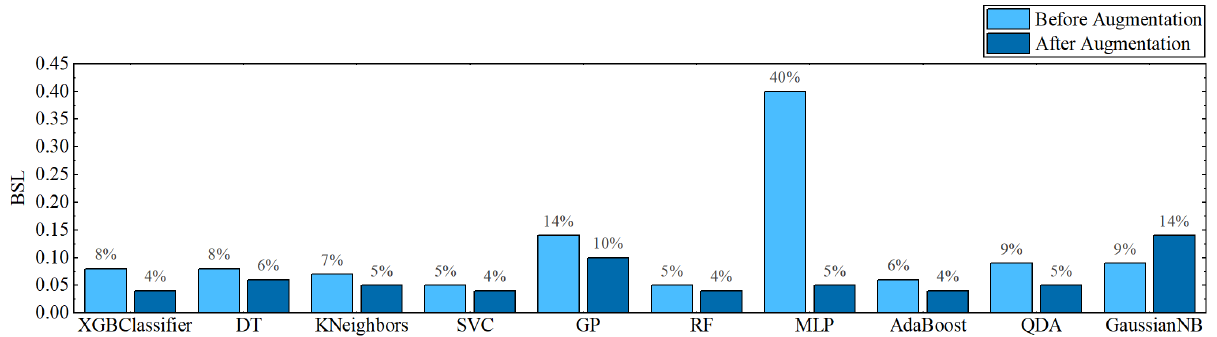
Figure 7. Balanced Accuracy results before and after cleaning and augmentation.